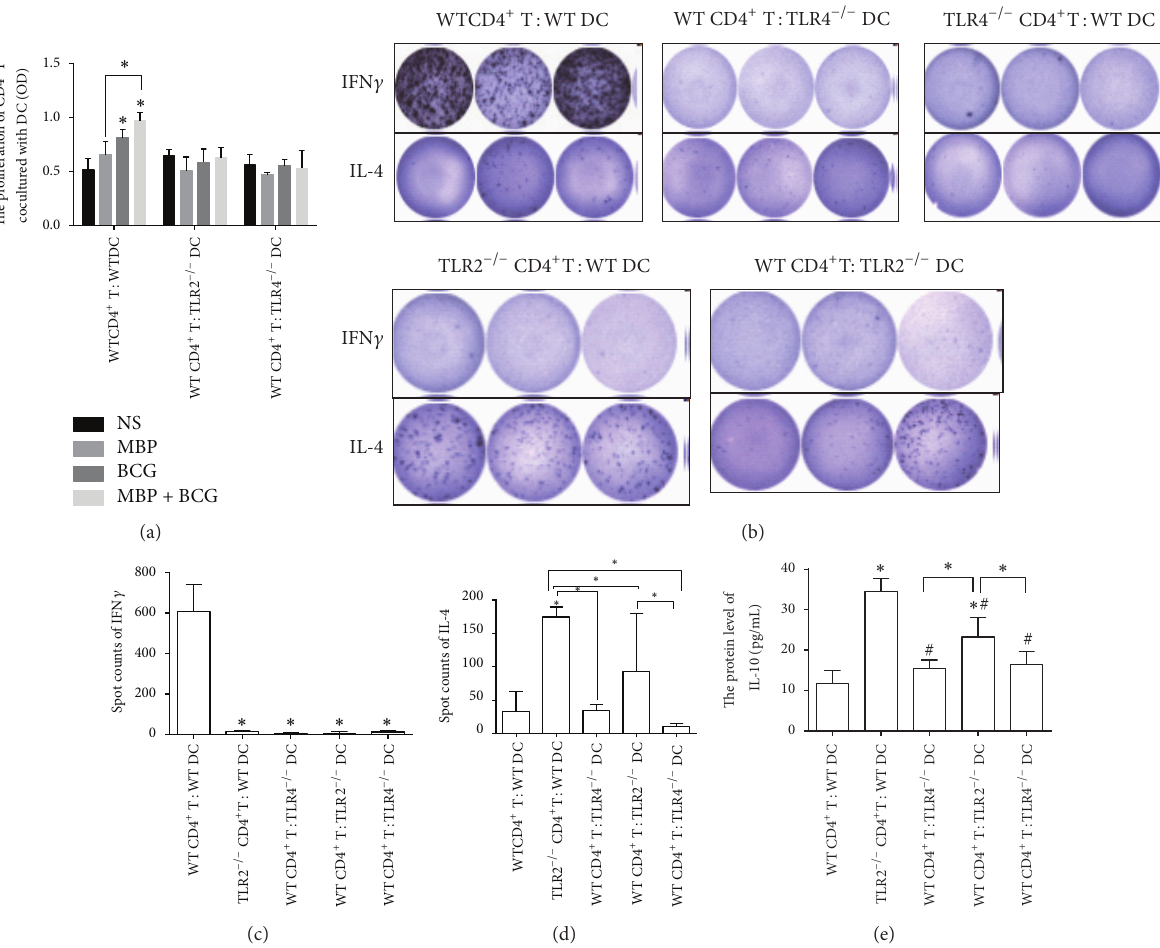
Figure 6: The direct and indirect effect of TLR2 and TLR4 on the production of cytokines in CD4 + T cells cocultured with DCs treated with the combination of MBP and BCG. (a) The function of TLR2/TLR4 expressed on DCs in the proliferation of CD4 + T cells from normal mice. CD4 + T cells from normal mice cocultured with DCs form TLR2 −/− mice or TLR4 −/− mice were stimulated with the combination of MBP and BCG for 48 h. The proliferation of CD4 + T cells was assayed with the CCK8 method. Data are expressed as the mean ± standard deviation and are shown in a bar graph. (b) Spots were counted by an ELISPOT reader. (c) ELISPOT cells showing IFN- 𝛾 production by CD4 + T cells cocultured with DCs from different groups after incubation with the combination of MBP and BCG. (d) ELISPOT cells showing IL-4 production by CD4 + T cells cocultured with DCs from different groups after incubation with the combination of MBP and BCG. (e) ELISA was used to detect the production of IL-10 in CD4 + T cells cocultured with DCs from different groups treatment with the combination of MBP and BCG. ∗ 𝑃 < 0.05 is considered to indicate statistically significant differences compared with the coculture of CD4 + T cells from WT mice with DC cells from WT mice. # 𝑃 < 0.05 compared with coculture of CD4 + T cells from TLR2 −/− mice with DC cells from WT mice.